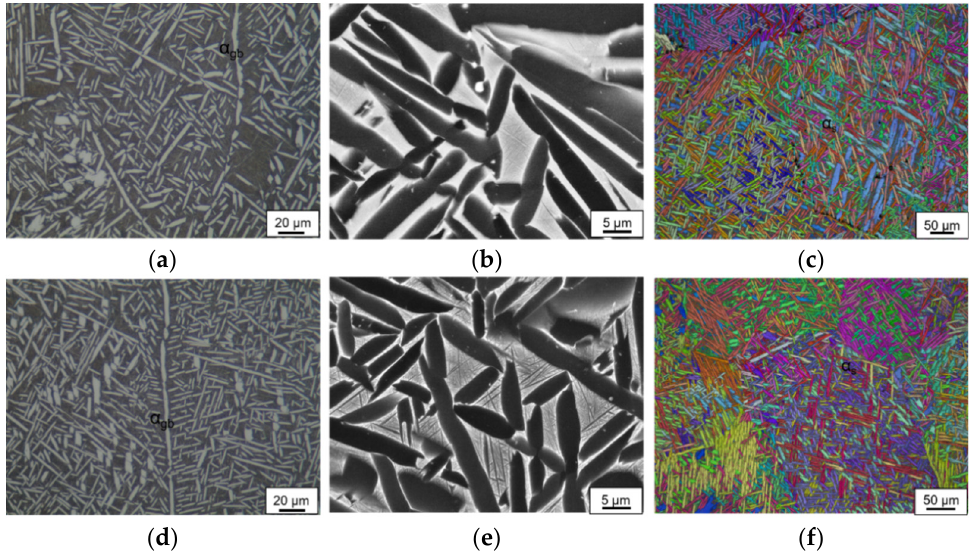
Figure 4. Alpha phases morphology in the samples after solution treatment at 980 °C and aged at 650 ( a – c ) and 750 °C ( d – f